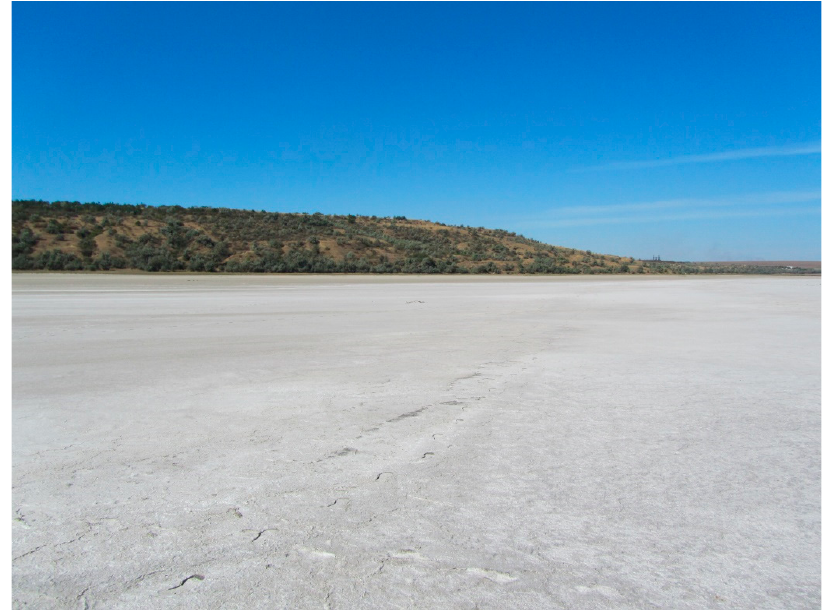
Figure 26. The water-free territory of the Kuyalnik Estuary in the summer-autumn period (surroundings of Kovalivka village).